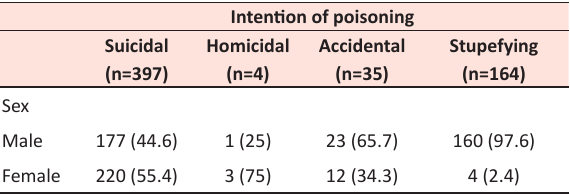
Table 4. Association between sex and intention of poisoning (n = 600)